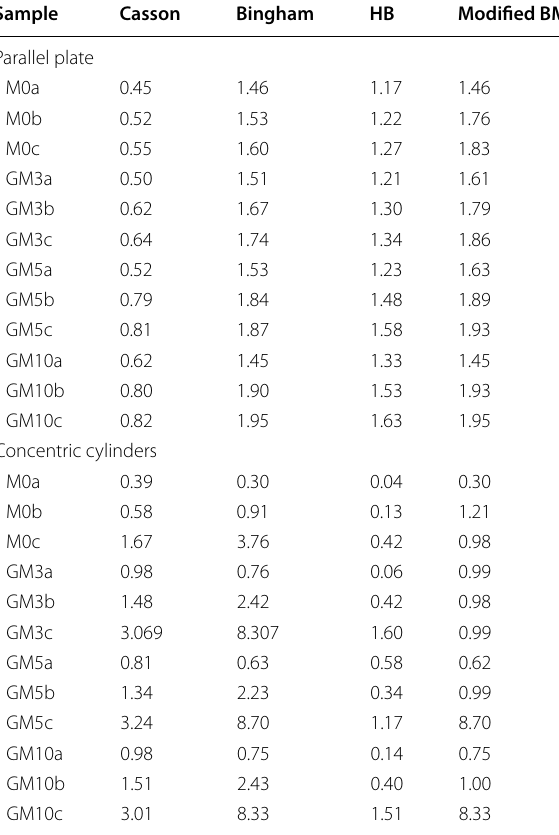
Table 6 Effect of shear rate range on yield stress values. Sample